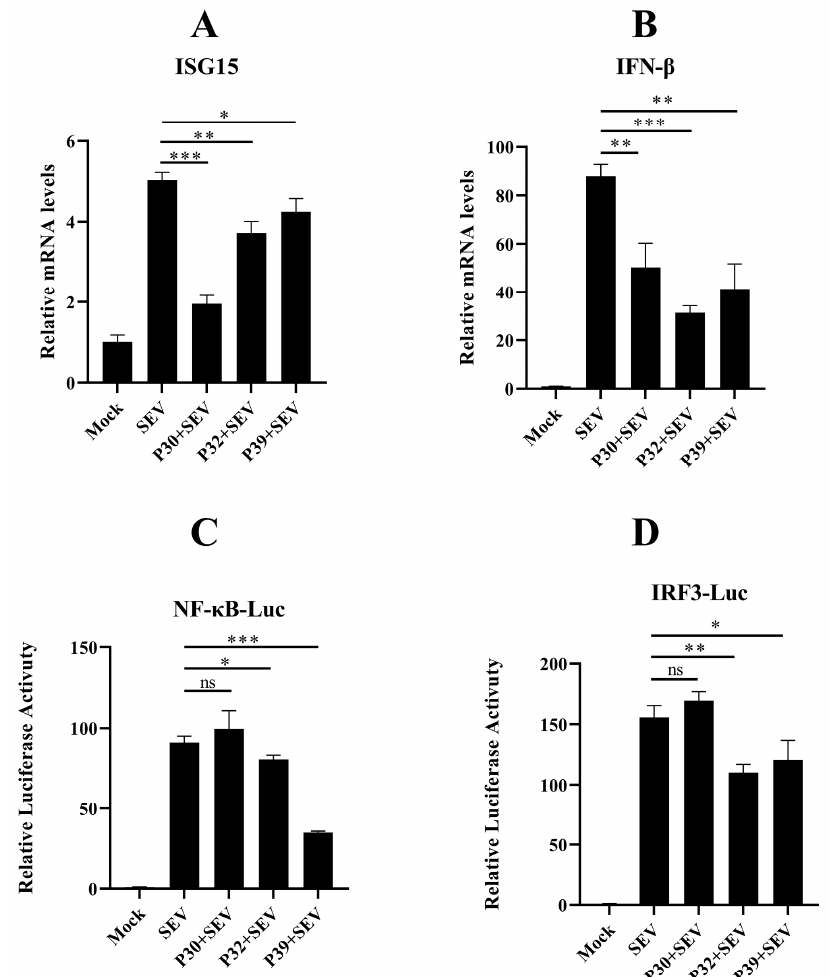
Figure 7. P30, P32, and P39 inhibit innate immune response. ( A , B ) HEK 293T cells were transfected with different plasmids, total RNA was extracted from the cells at the indicated time points, and the mRNA levels of IFN- β and ISG15 were measured by qPCR. ( C , D ) In the dual luciferase assay, CRFK cells were transfected with different plasmids for 24 h, inoculated with SeV and incubated for another 12 h, and lysed for determination of luciferase activity. P30, P32, and P39 inhibited SeV-activated IFN- β and ISG15 expression at the mRNA level. Second, the results of the dual luciferase assay showed that P32 and P39 blocked the activation of the NF- κ B and IRF3 promoters. (ns—not significant, * p < 0.05, ** p < 0.01, *** p < 0.001).